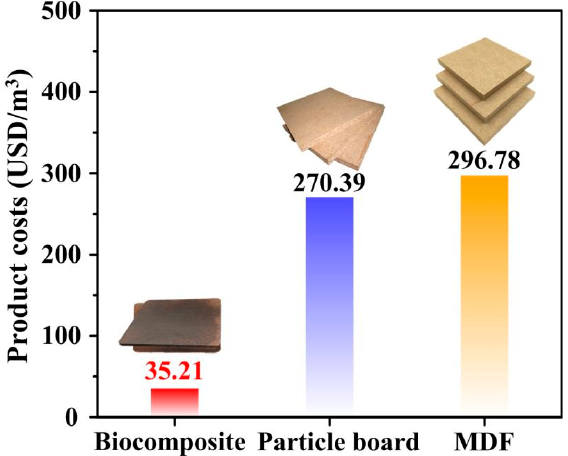
Figure 8. Production costs of biocomposites, particle board and